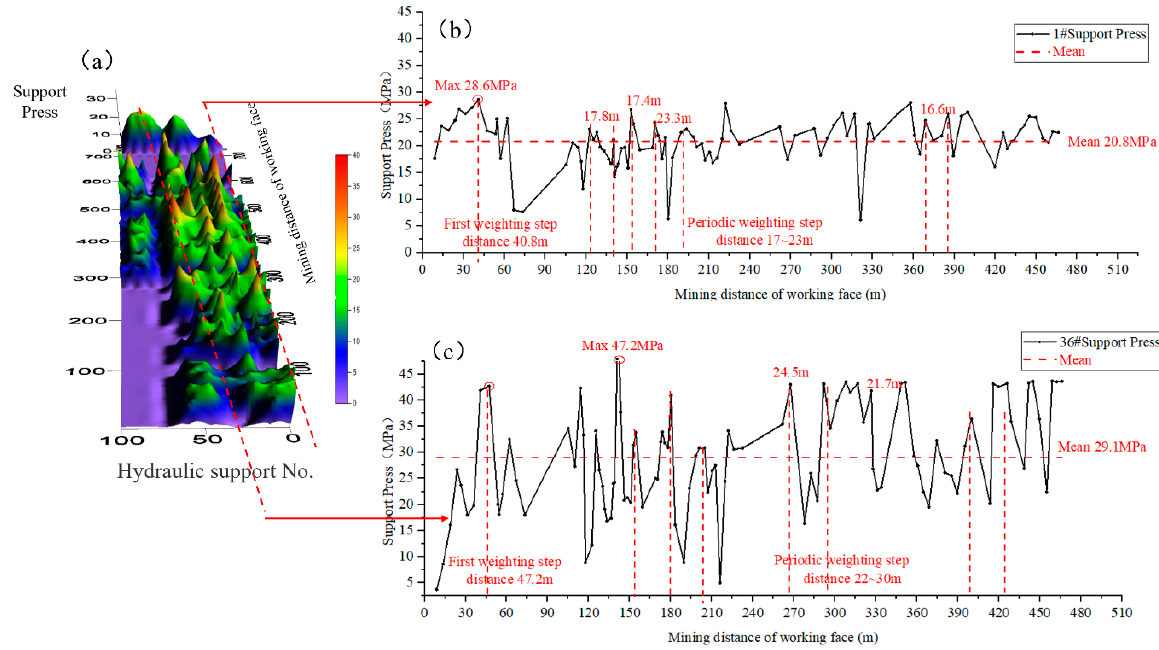
Figure 12. The hydraulic support pressure curve ( a ) Time–space pressure cloud graph of hydraulic support ( b ) 1# hydraulic support press curve ( c ) 36# hydraulic support press curve